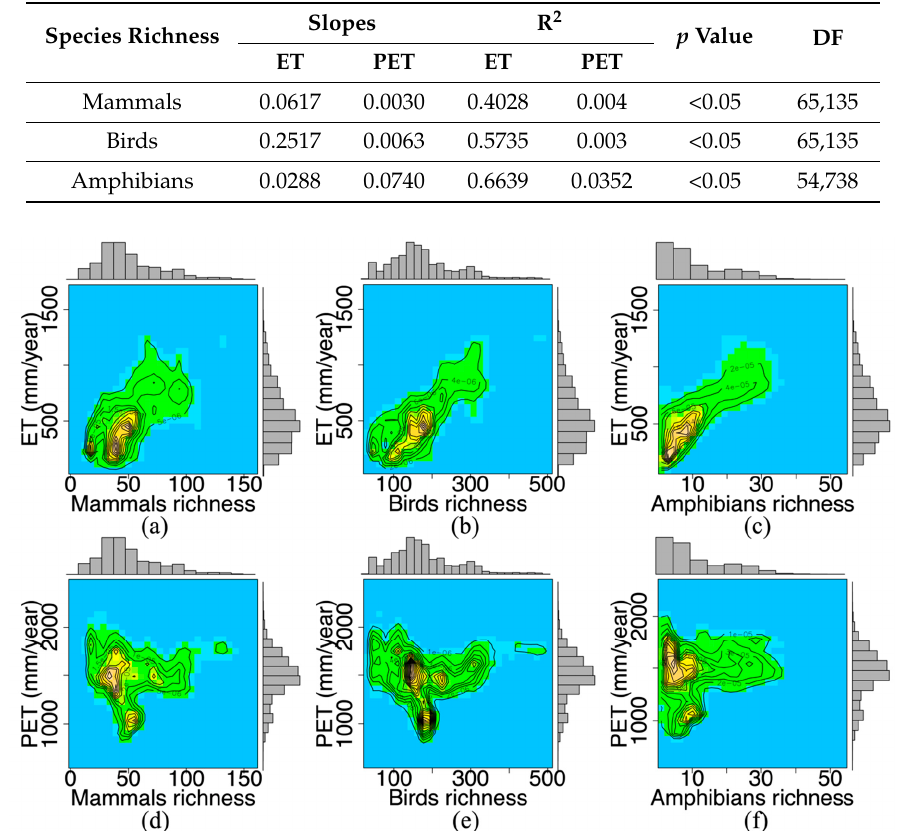
Figure 3. Frequency distributions of species richness based on field surveys versus long-term averages of evapotranspiration (ET) and potential evapotranspiration (PET, 2000–2013) are presented in (x,y)-format with respect to ( a ) (Mammals, ET); ( b ) (Birds, ET); ( c ) (Amphibians, ET); ( d ) (Mammals,